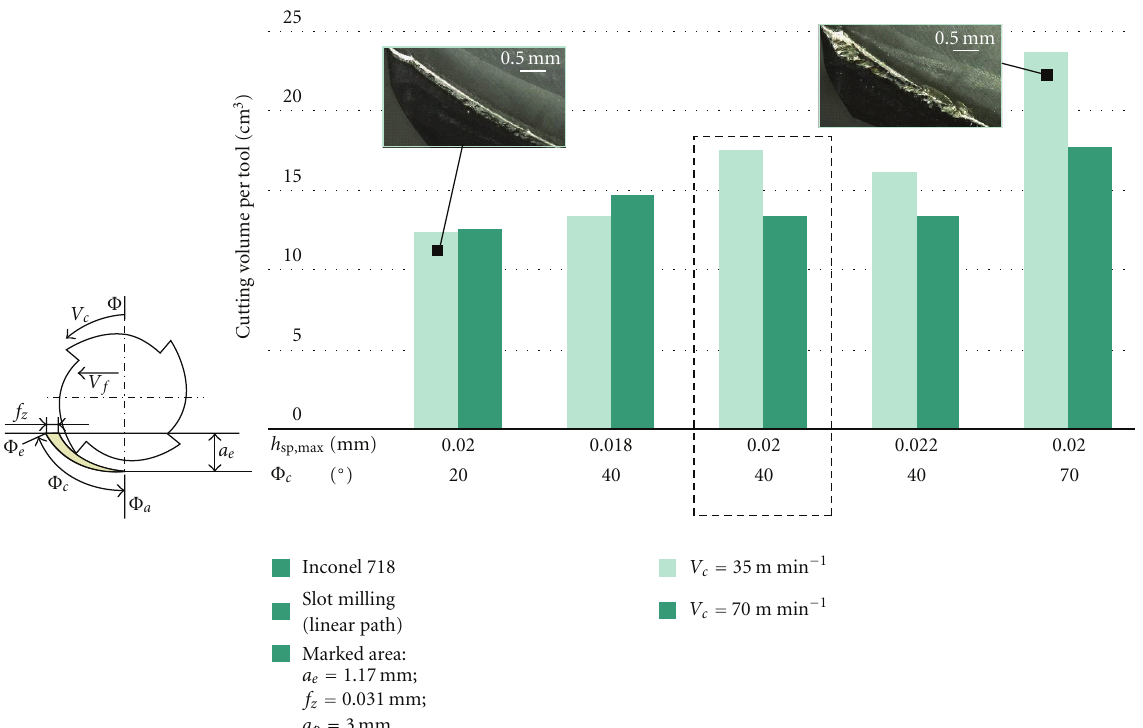
Figure 9: Influence of the tool engagement and the cutting velocity on the tools’ cutting volume.